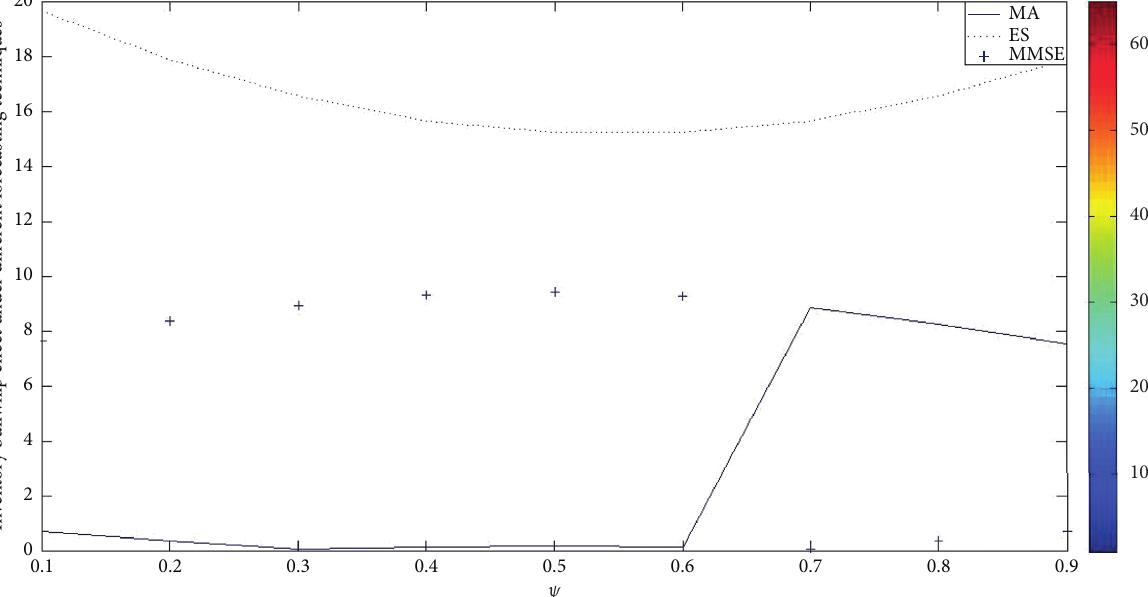
Figure 13: The impact of ψ on the inventory bullwhip effect using different forecasting